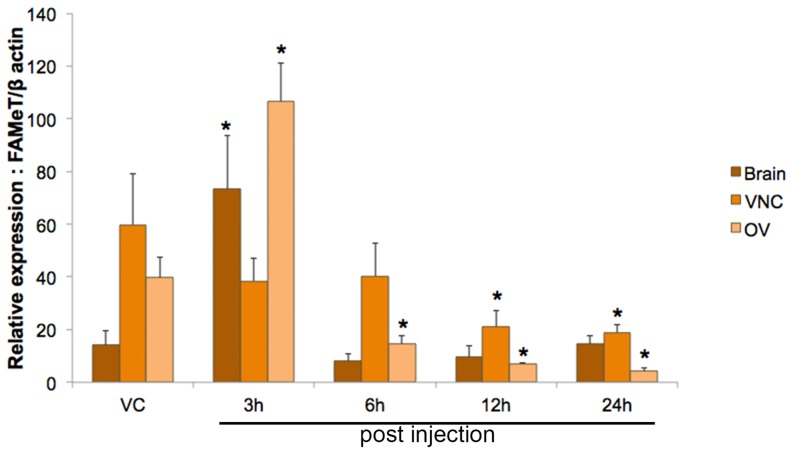
Effect of priming 5-HT on relative FAMeT gene expression level in S. olivacea using quantitative RT-PCR.
FAMeT mRNA expression levels in the brain, VNC and ovary (n = 12) were determined at 3, 6, 12 and 24 h post 5-HT injection. Data were normalized against β-actin. Asterisks indicate significant differences (p<0.05) with respect to the control (vehicle-injected) group. Abbreviations: farnesoic acid o-methyltransferase (FAMeT), ventral nerve cord (VNC), ovary (OV), and vehicle control (VC).